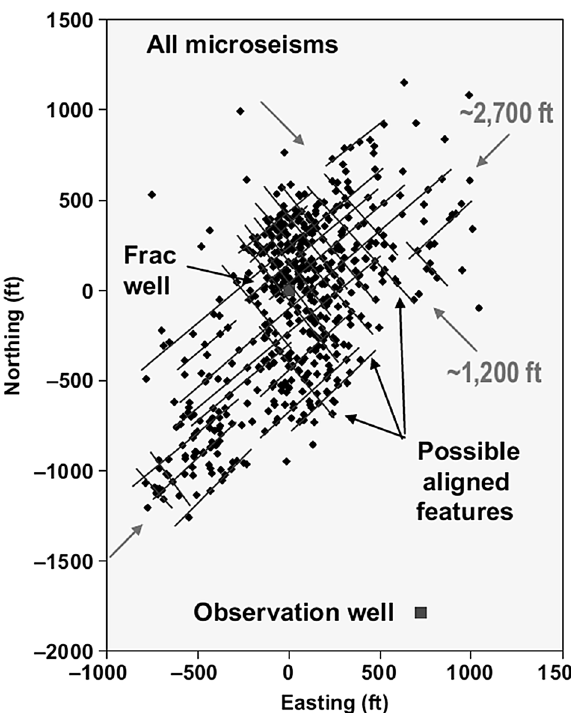
Fig. 1 Microseismic fracture map with complex fracture network in shales (Warpinski et al.